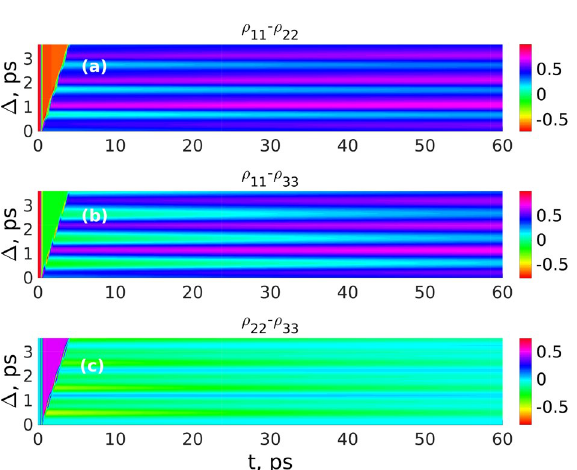
ρ 22 ( a ), ρ 11 ρ 33 ( b ), ρ 22 ρ 33 ( c ) on the delay − − − 0.97 THz, = 150 kV/cm, τ 250 ps, T 21 5 150 fs, T 22 T 33 T 32 T 31 p = = = = = = =